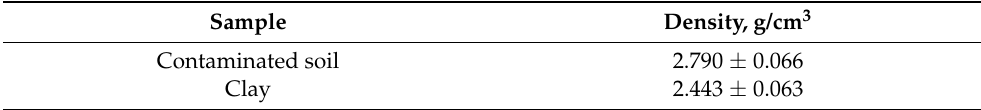
Table 2. Particle density of the contaminated soil and clay.